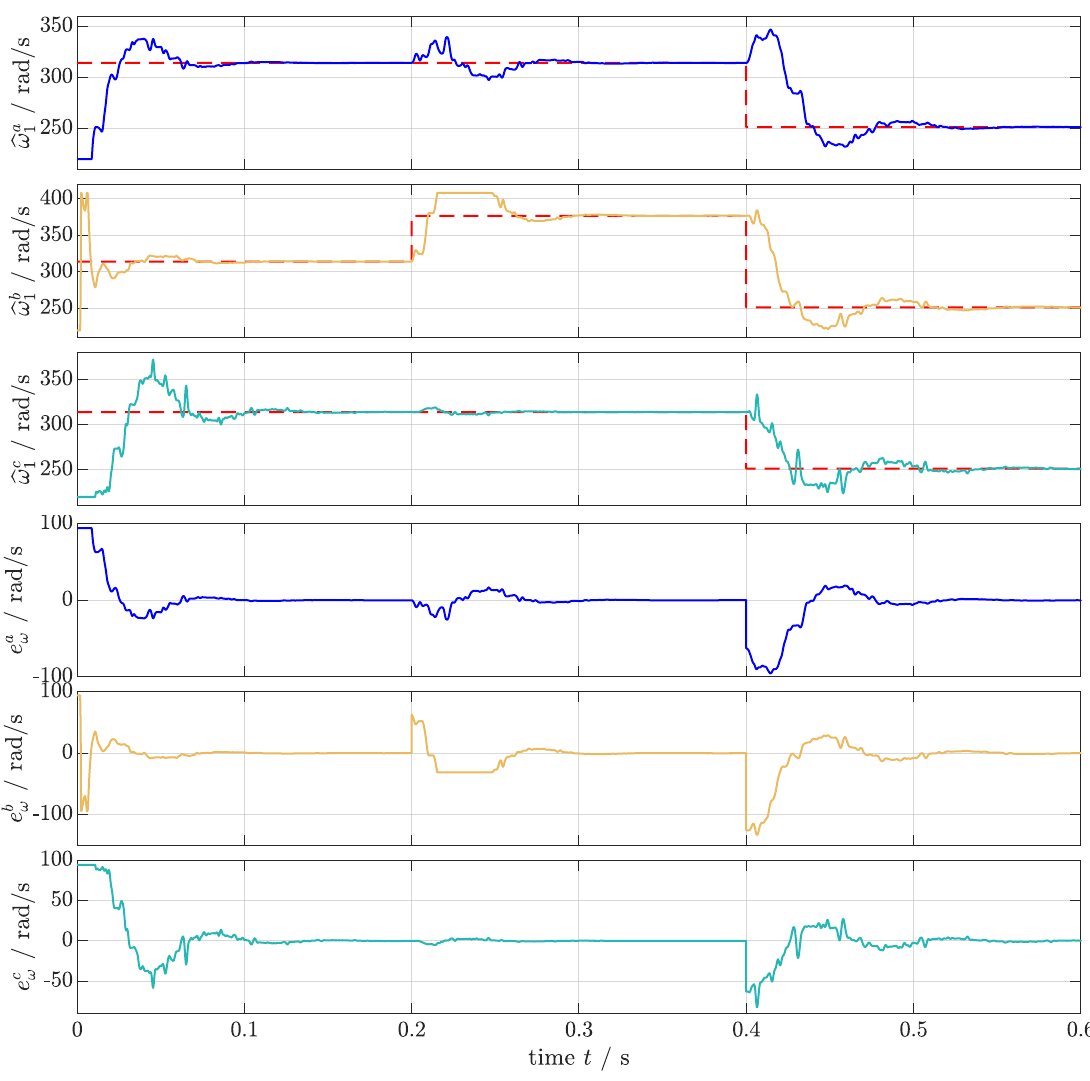
b c 1 , ω 1 & ω 1 ( ), and its positive- (cid:98) y abc + , negative- ,2